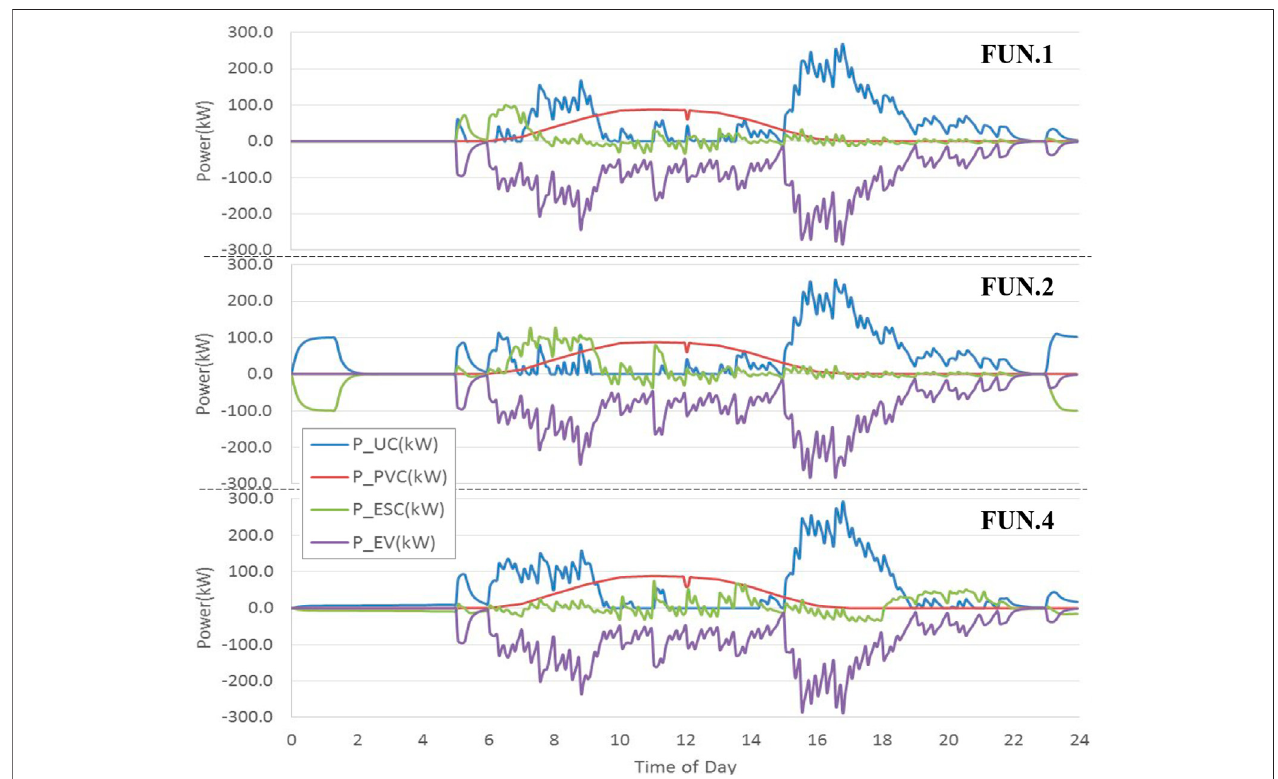
FIGURE 9 | Power fl ow of each converter using FUN.1, FUN.2, and FUN.4.